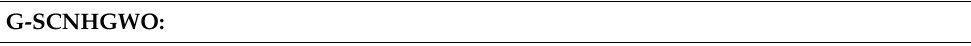
Algorithm 1: Pseudocode of G-SCNHGWO